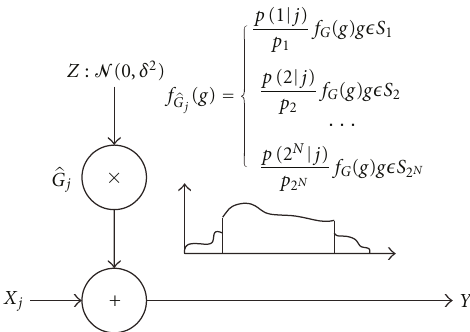
Figure 8: Channel model for a given X j in the presence of unreliable quantization region